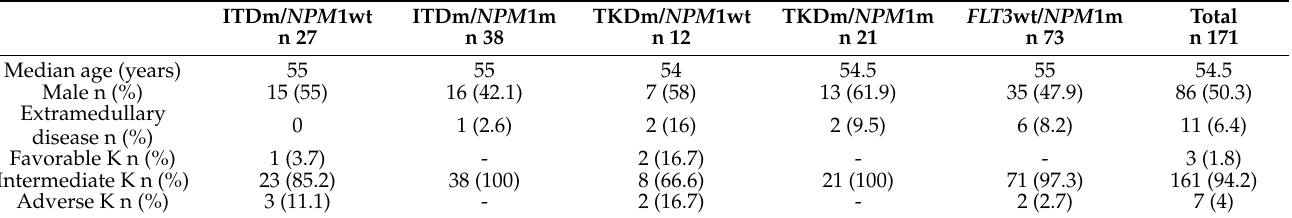
Table 1. Characteristics of 171 NPM1 or FLT3 -mutated patients (study cohort), divided according to molecular